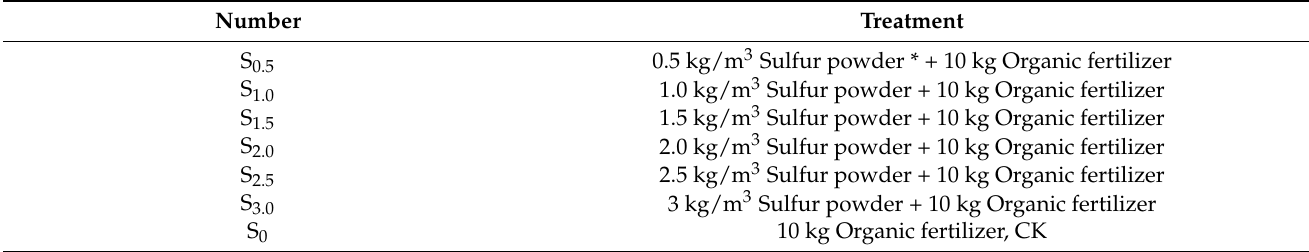
Table 2. The concentration of sulfur